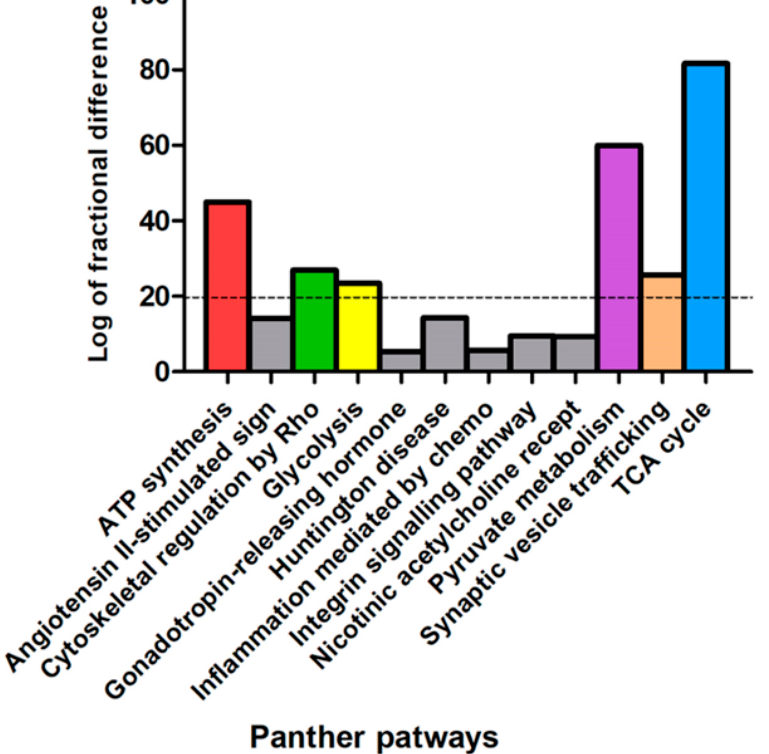
Figure 2. PANTHER pathways classification of murine NAGLU − / − brain tissue proteome. The dysregulated proteins in NAGLU − / − brain versus murine WT brain proteomes were clustered according to their cellular pathways using the Protein Analysis Through Evolutionary Relationship (PANTHER) software. The PANTHER pathways graphical enrichment ( y -axis) was associated to each cellular pathway ( x axis). The PANTHER cellular pathways were listed according to enriched values, expressed as the log of fractional di ff erence (observed vs expected): (number of genes for the category – number of genes expected) / (number of genes expected).